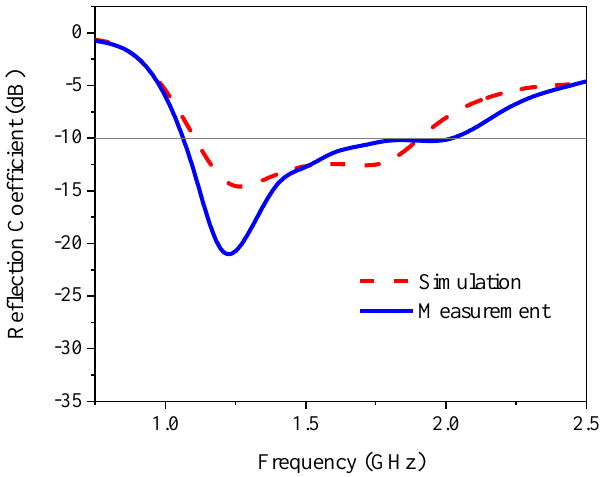
Figure 18. The simulated and measured reflection coefficient of the proposed antenna.